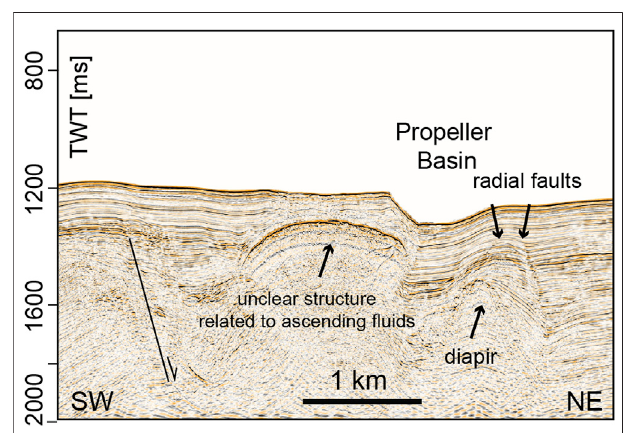
FIGURE 13 | Seismic re fl ection pro fi le PB07 showing the normal faults that can be traced along the Propeller Basin. Location in Figure 2A